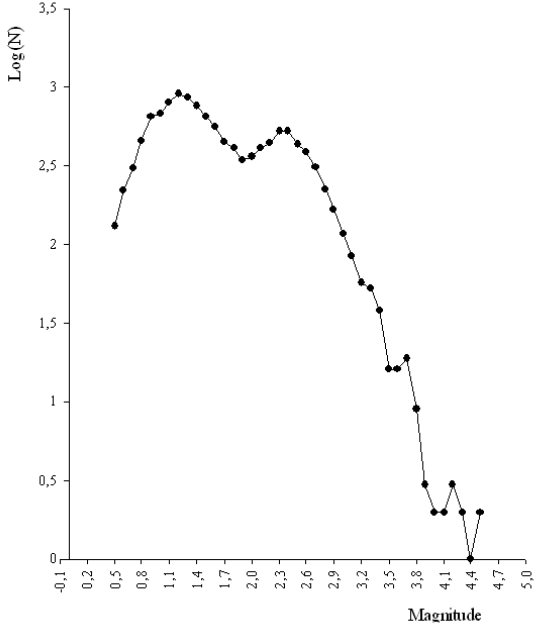
Figure 3. Non-cumulative frequency–magnitude distribution, in the period 1983–2013, denoting the changes of catalogue complete-